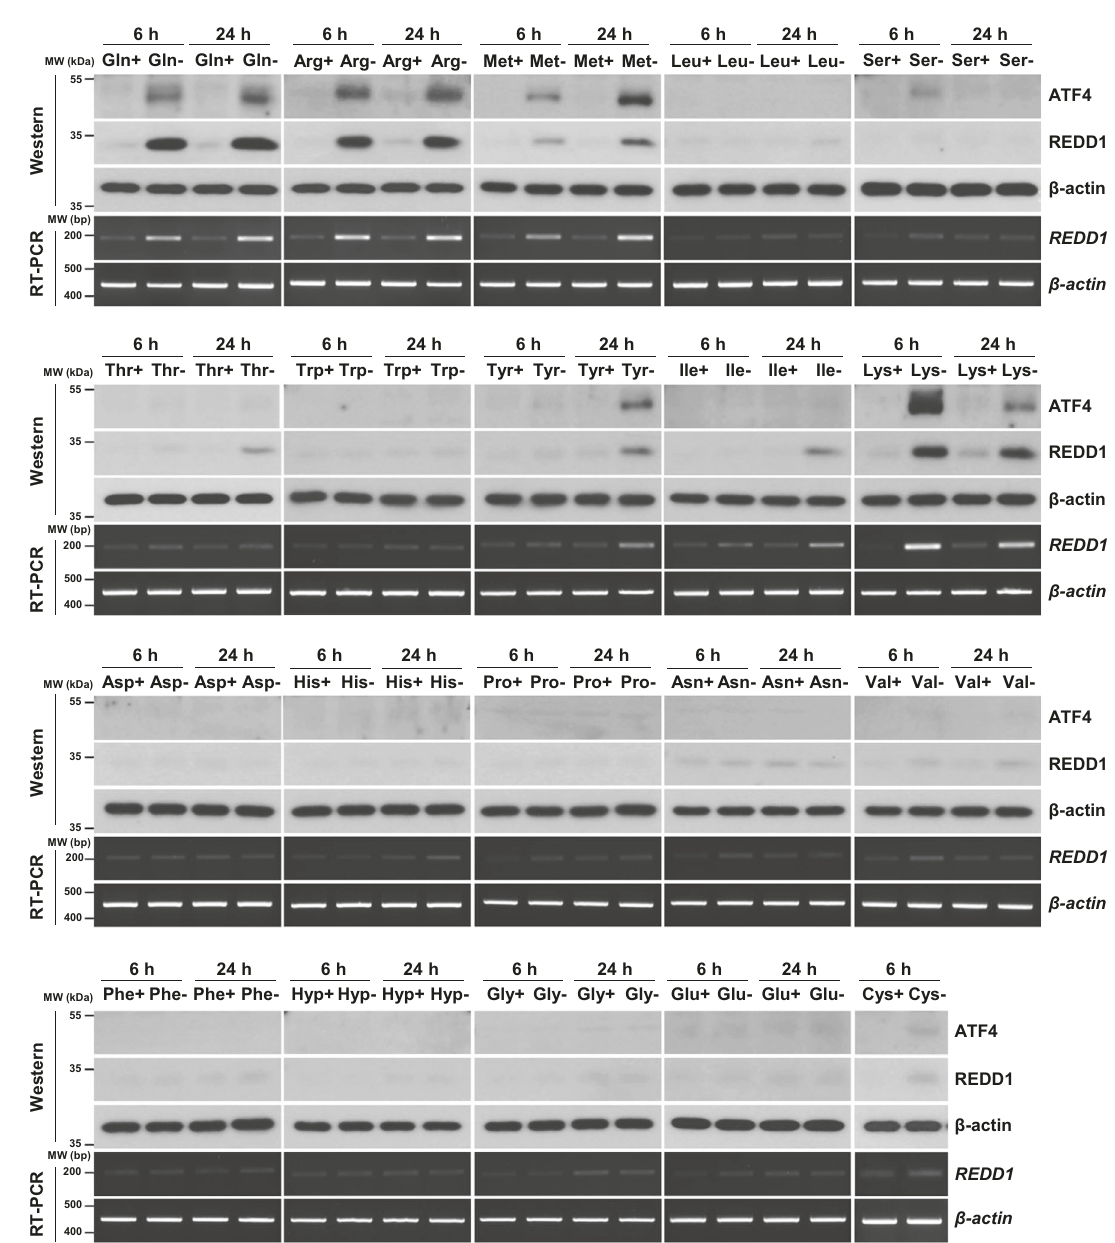
Fig. 1 REDD1 and ATF4 expression in individual amino acid - de fi cient conditions. H1299 cells were deprived of each one of 20 amino acids in medium for 6 or 24 h. The levels of ATF4 and REDD1 protein and REDD1 mRNA were measured by western blot and RT-PCR analysis,